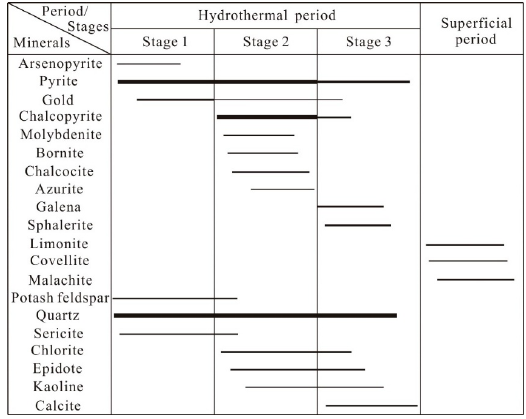
Figure 6. Mineral paragenesis for the Jinchang gold deposit.